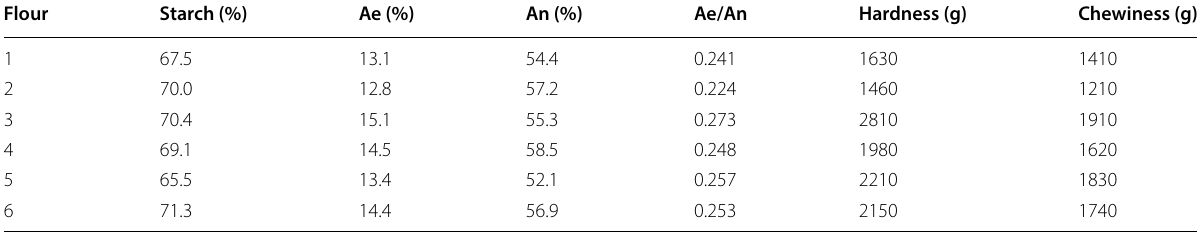
Table 3 Effect of Ae/An ratio on the hardness and chewiness of CSB